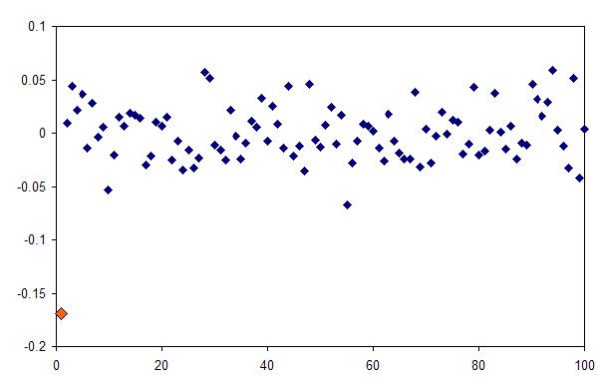
Randomisation. Results of the randomisation study on the DIP_Core dataset. The first marker (red) represents the correlation of the original dataset. All other markers show the correlations of the 100 randomly sampled datasets.